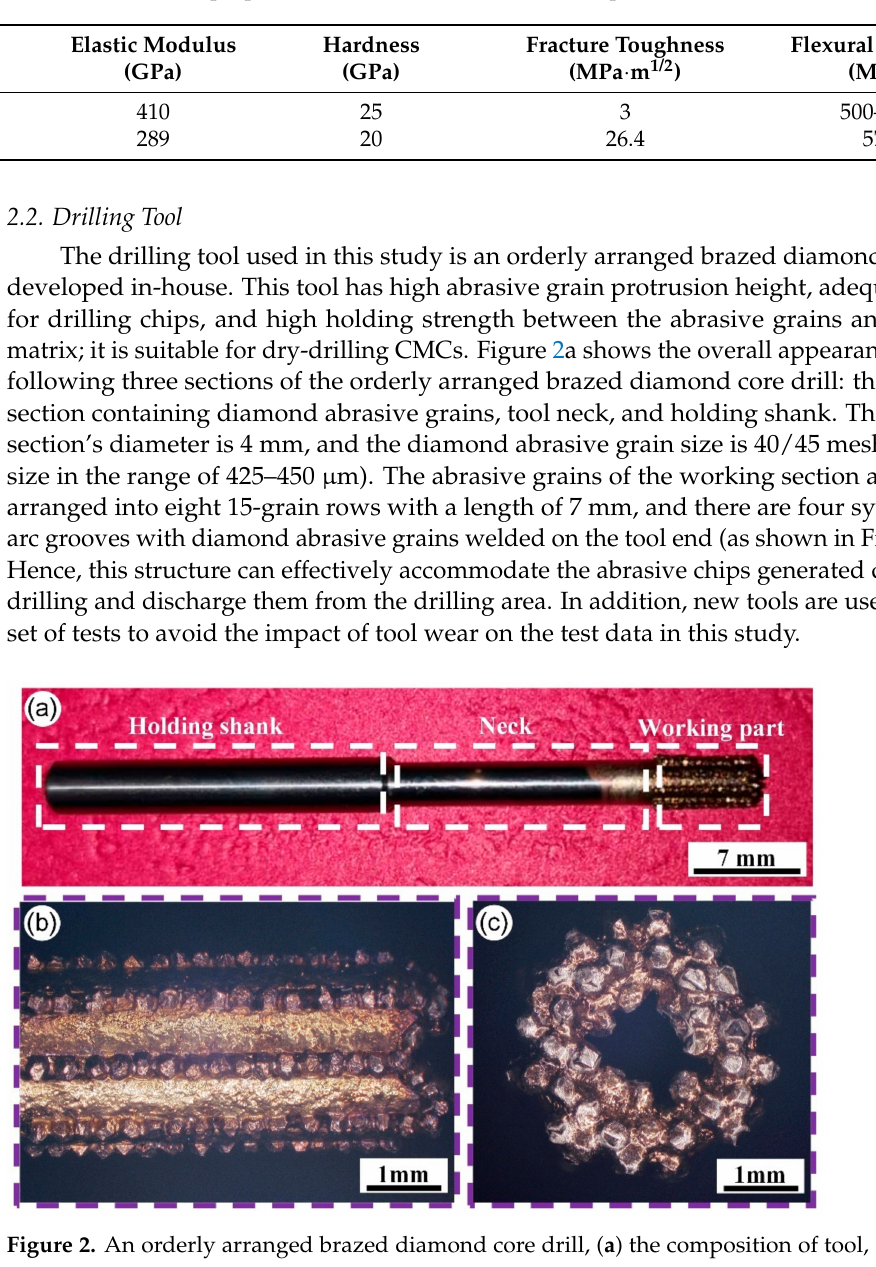
Table 1. Mechanical properties of the SiC and SiC f /SiC workpiece [31,32].